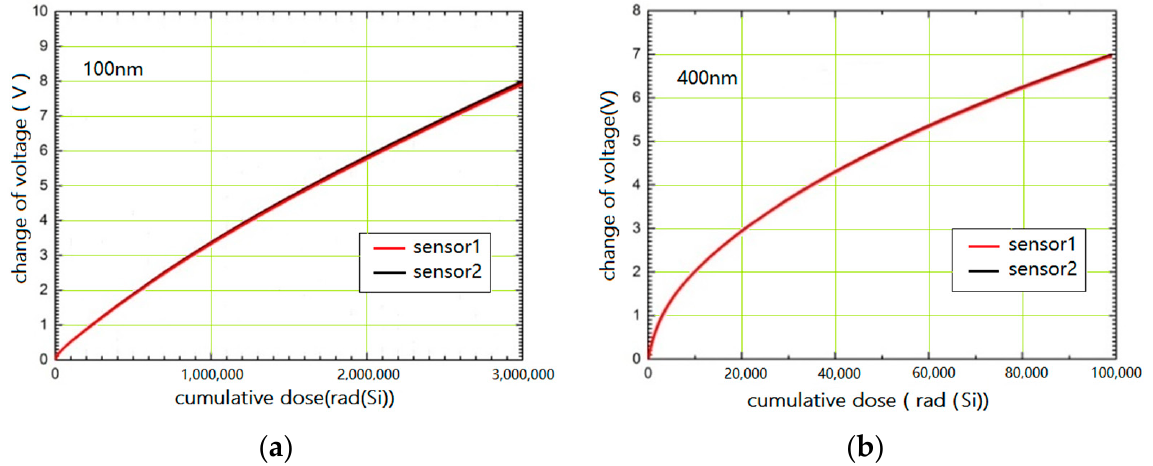
Figure 2. Received irradiation dose and corresponding voltage output of PMOS sensors. ( a ) Received irradiation dose and corresponding voltage output of the 100 nm PMOS sensor. ( b ) Received irradiation dose and corresponding voltage output of the 400 nm PMOS sensor.